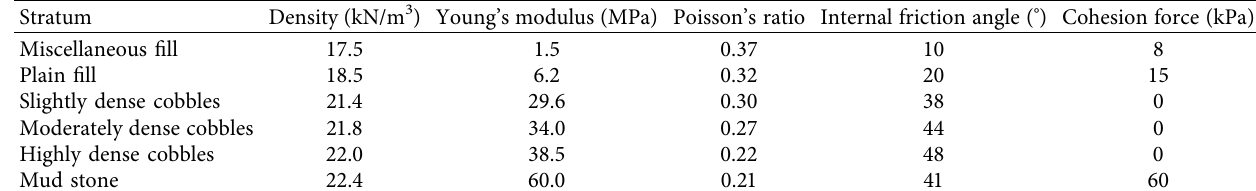
Table 2: Mechanical parameters of